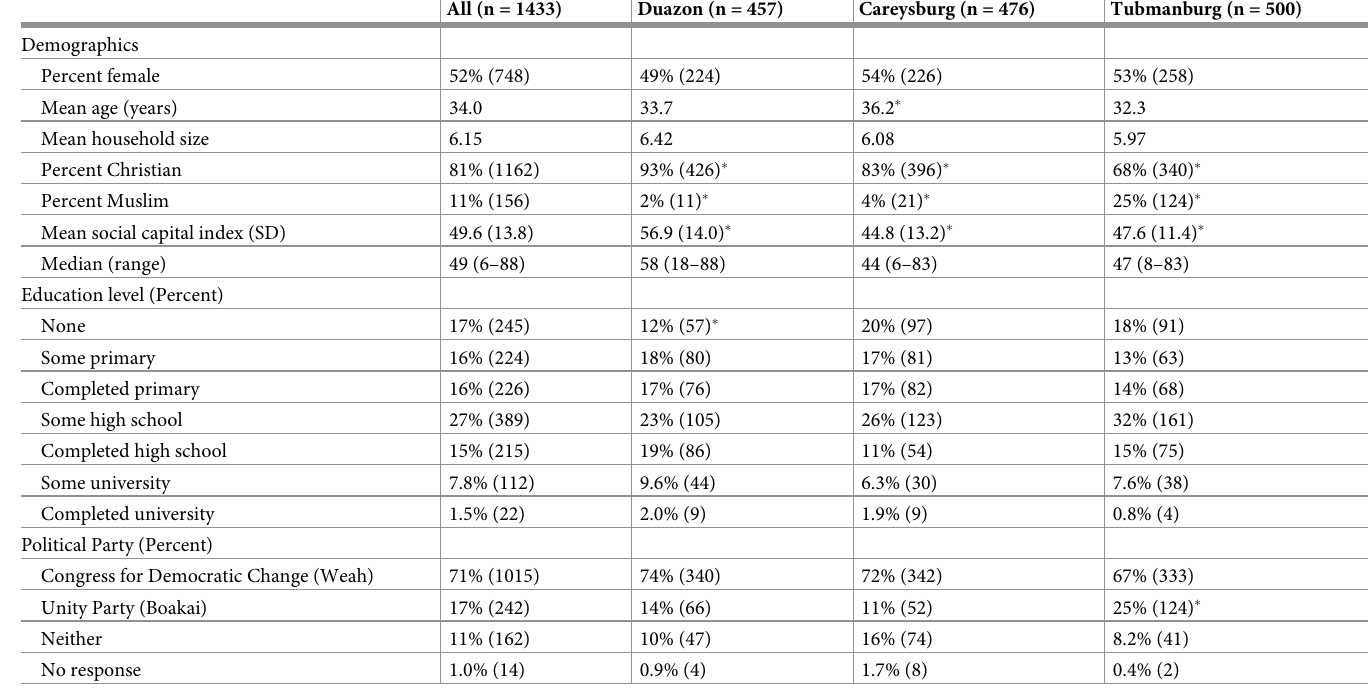
Table 1. Descriptive statistics of respondents (N = 1433) in aggregate and in each of three study locations: Duazon (peri-urban, high Ebola exposure), Careysburg (rural, low exposure), and Tubmanburg (urban, high incidence). � indicates value for this region is significantly different ( p < 0.05) than the other two regions according to a Fisher’s Exact test used pairwise for proportions and a t-test used pairwise for numeric variables. All (n =